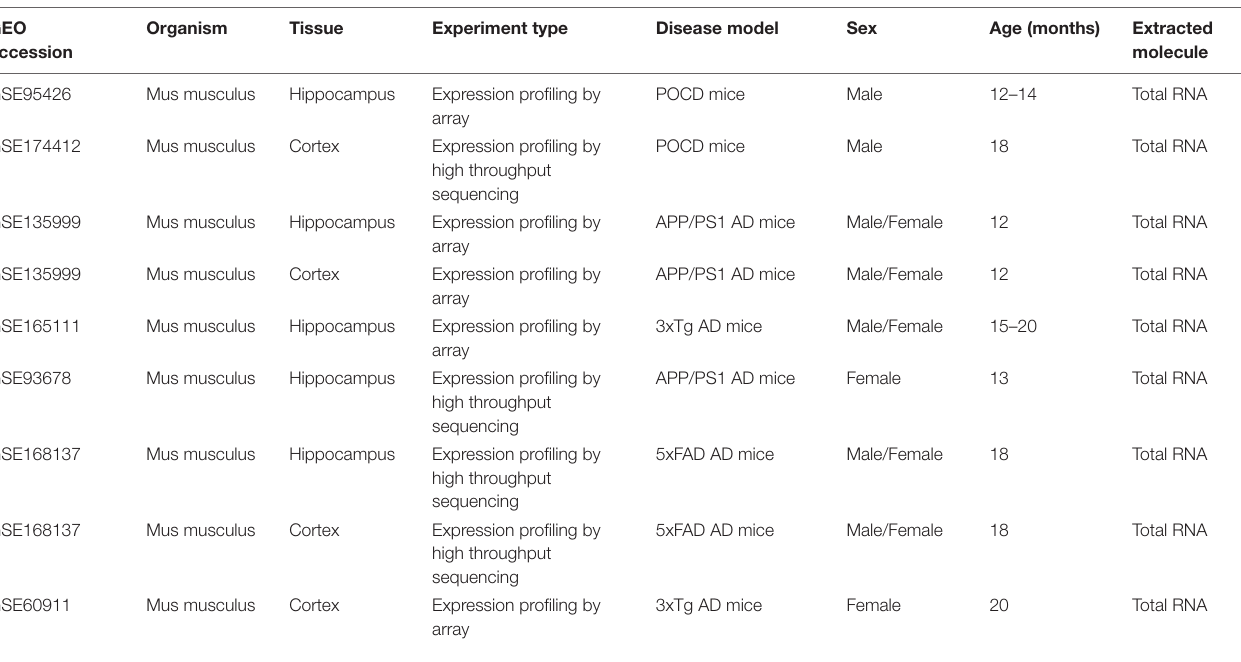
TABLE 1 | Dataset